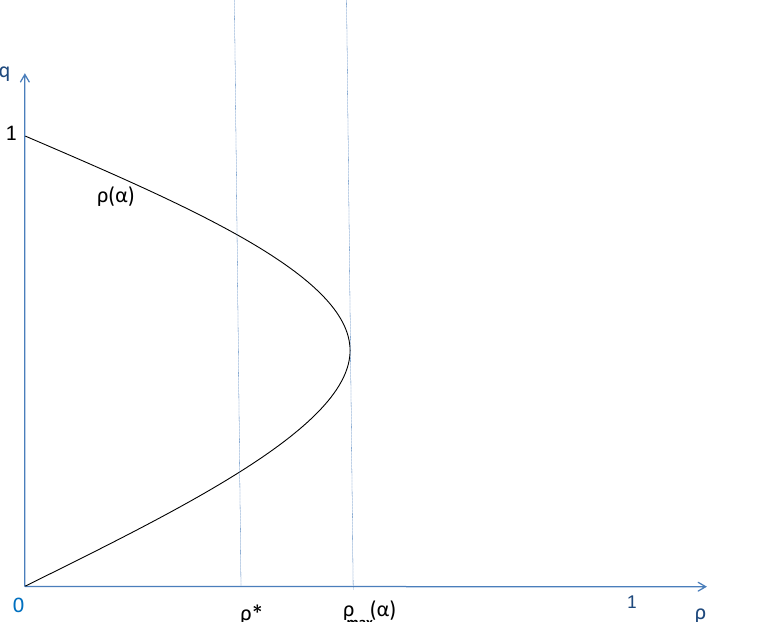
Figure 4. This figure compares the case where the level of the institution is exogenously settled at ρ ∗ to the case where the population can decide endogenously the degree of social segmentation associated to the institution, ρ ( α )